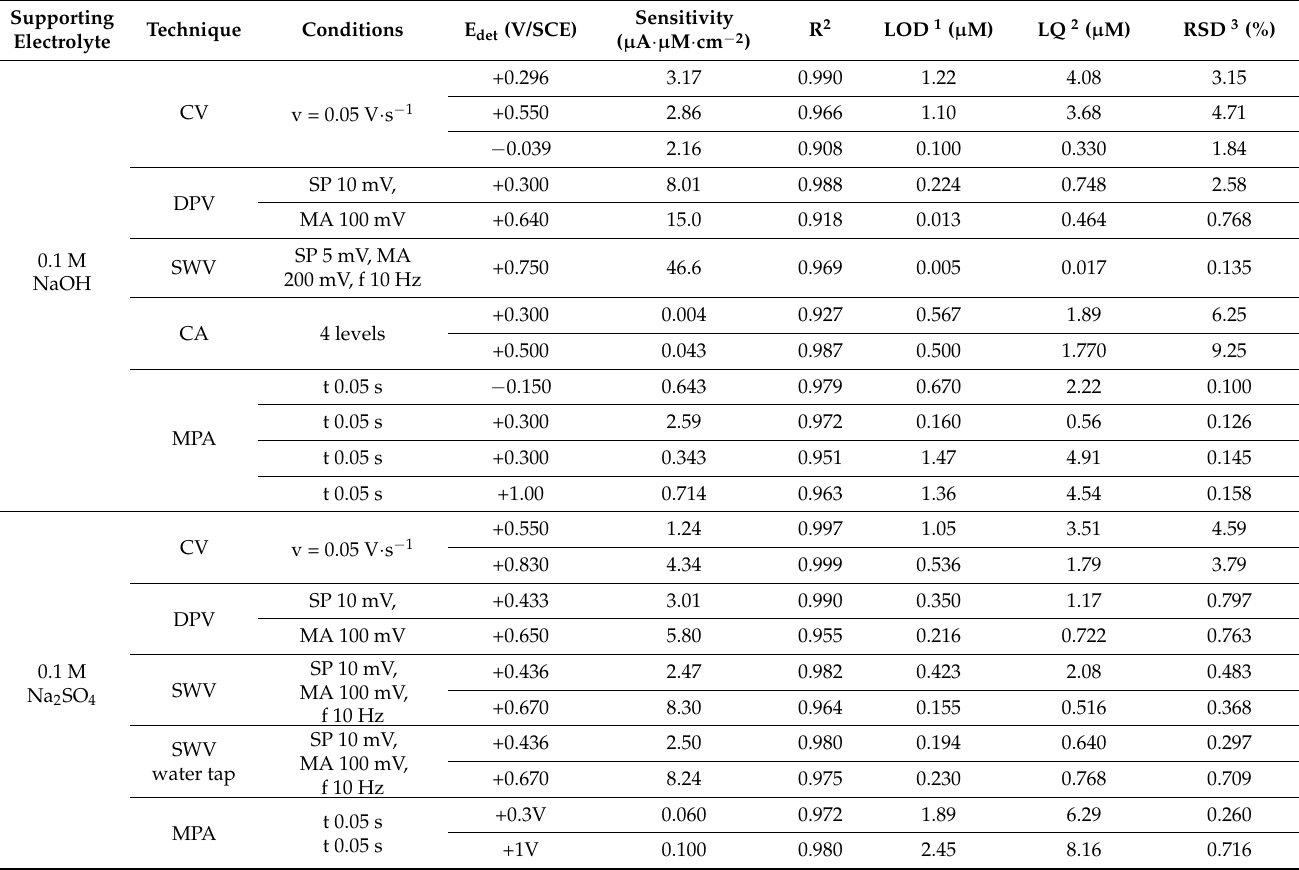
Table 5. Electroanalytical performance of Ag/GO/BDD electrode for TC detection in aqueous solution. Supporting Electro-